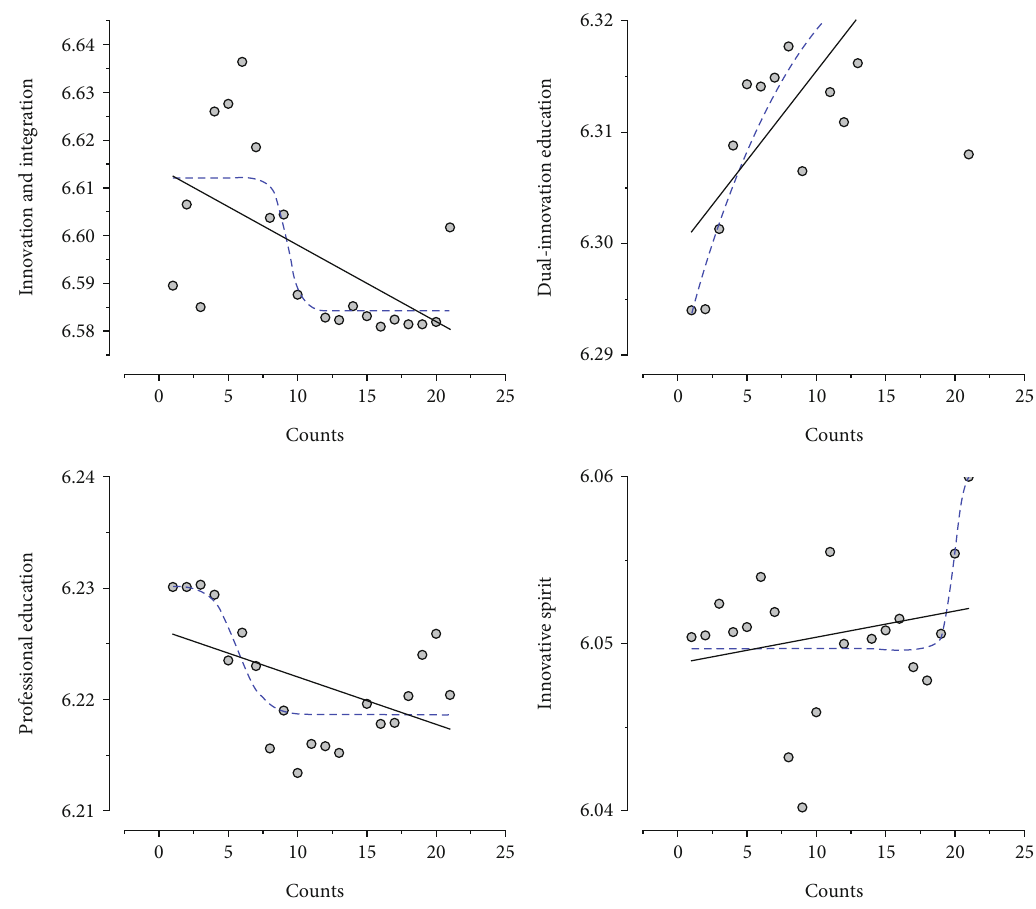
Figure 3: Analysis of the variability of innovation and entrepreneurship at di ff erent levels of